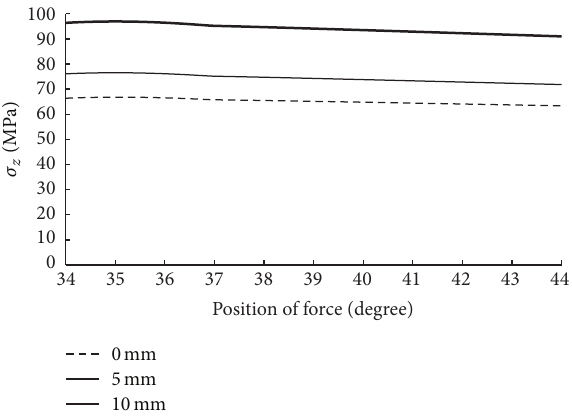
Figure 9: Variation of stress at z -direction for FCR of Model I under 4 N.